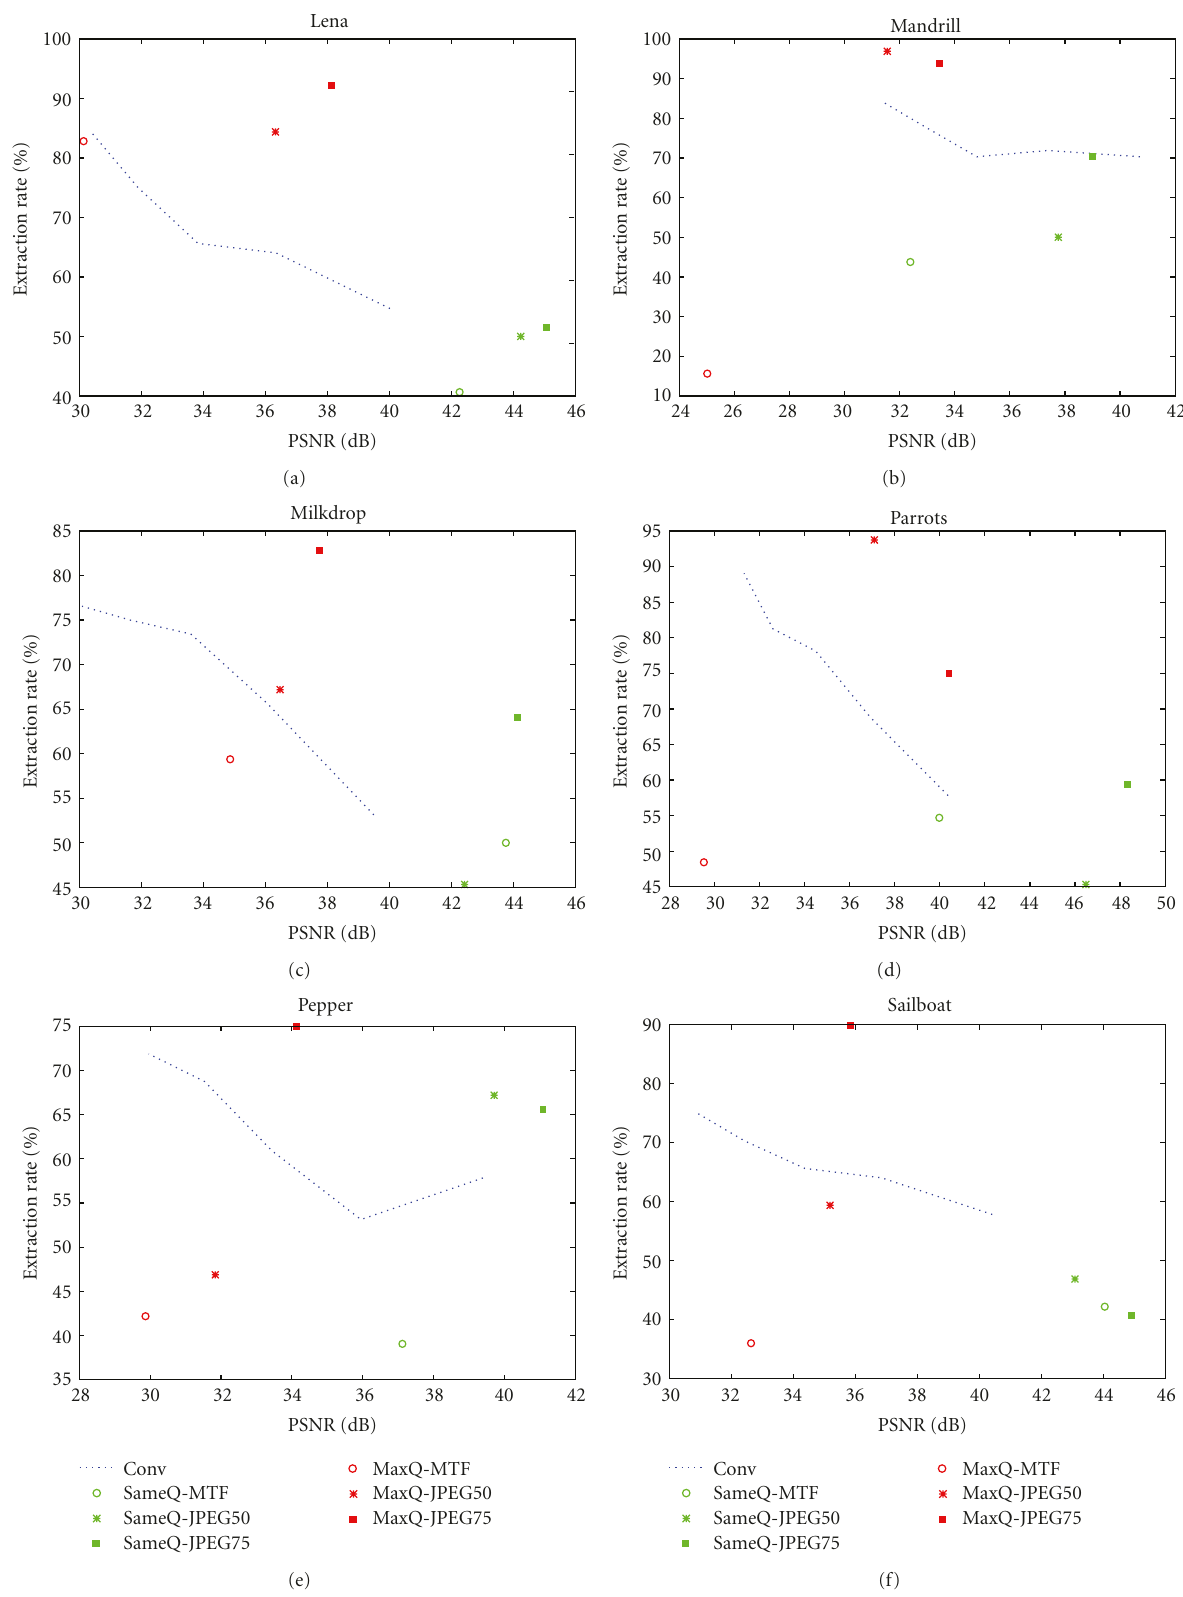
Figure 17: Comparison in the robustness against JPEG compression of quality 75%